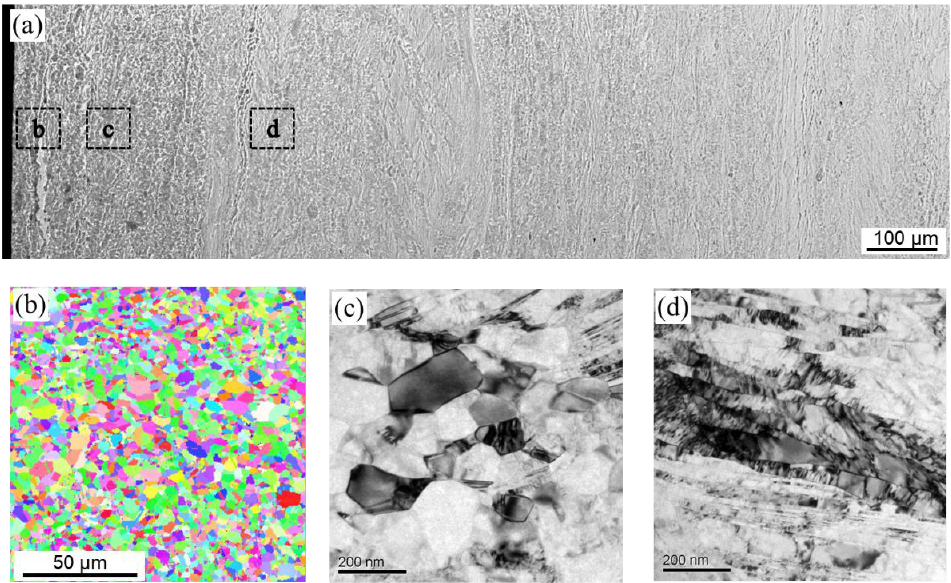
Figure 2. Typical microstructure of the inverse gradient nanostructure. ( a ) Overall picture. ( b ) EBSD image of the top-most surface. TEM image at depth of ( c ) 100 µm and ( d ) 250 µm. The homogeneous sample was obtained through elaborate annealing of the CR